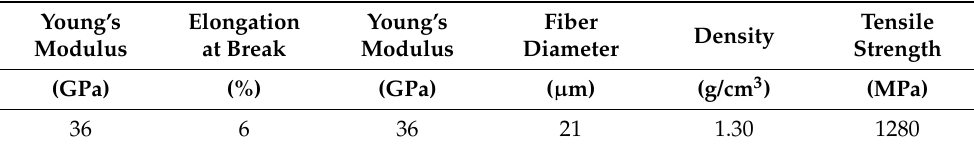
Table 1. Basic parameters of polyvinyl alcohol (PVA) fibers used in this study.